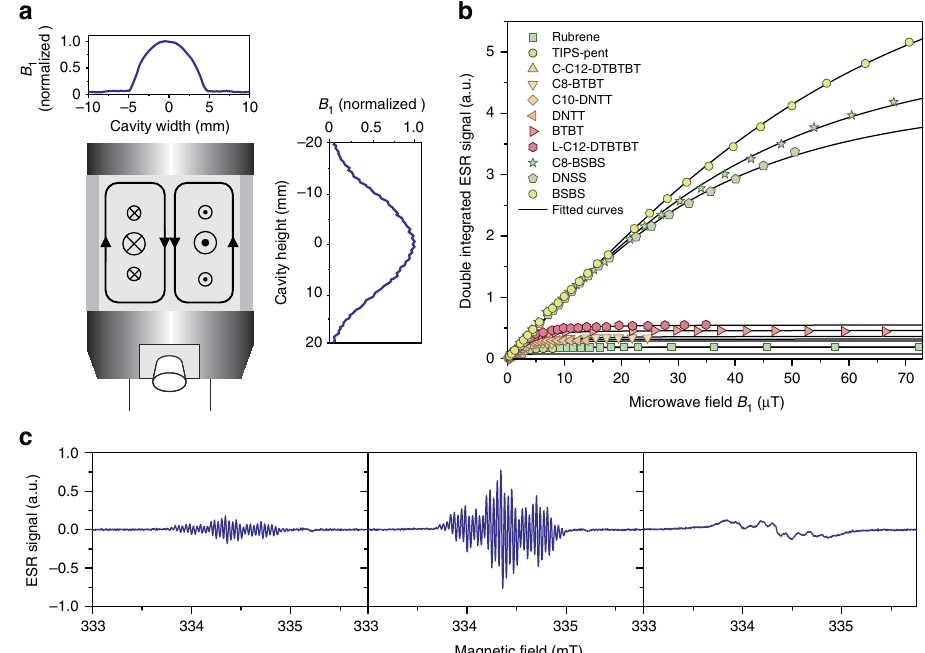
Figure 3 | Power-saturation measurement of spin lifetimes. ( a ) Schematic of the Bruker ER 4122SHQE cavity with microwave magnetic and electric fields in-plane and out-of-plane, respectively. Plot insets show the magnetic field strength across the cavity. We account for the vertical distribution of B 1 and minimize horizontal variations by confining our samples to a diameter of 1mm. ( b ) Power saturation of the integrated ESR absorption spectra for the series of molecules with fitted curves to extract T 1 and T 2 . ( c ) Evolution of derivative ESR spectrum with increasing microwave powers for the example of